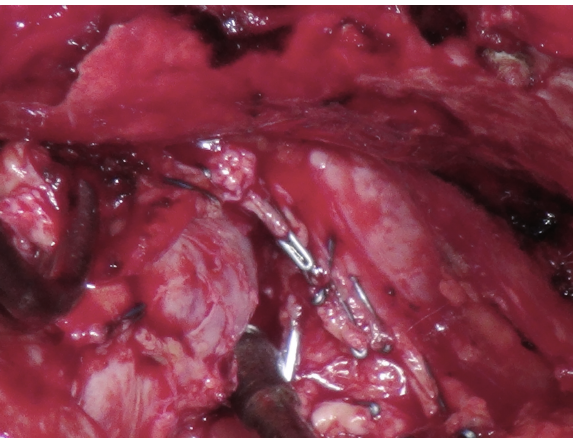
figure 2 - Antegrade prostate dissection including bilateral nerve sparing (radical retropubic prostatectomy).